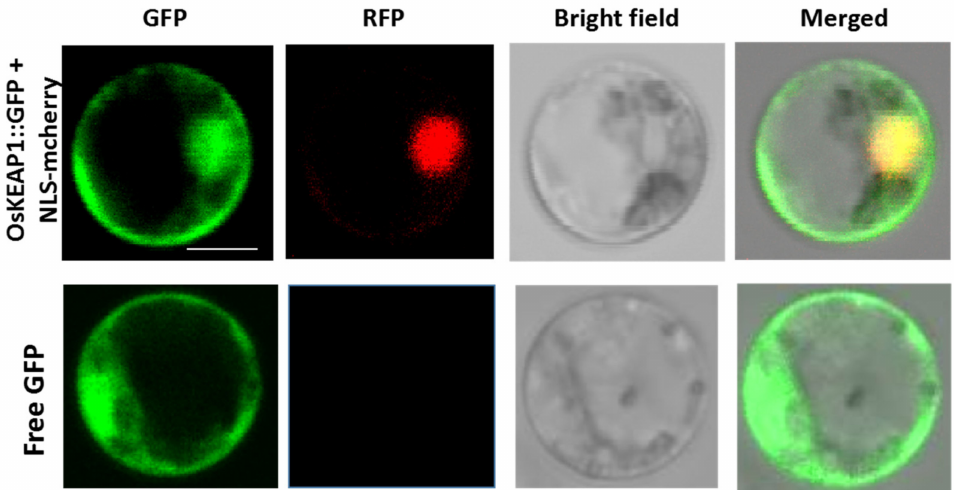
Figure 2. Transient expression of 35S:OsKEAP1:GFP fusion in rice protoplast. Protoplasts transfected with control vector (35S:GFP) have a bright GFP signal distributed throughout the cell, whereas those with 35S:OsKEAP1:GFP have a fluorescent signal (in green) localized in the nucleus and cytoplasm, confirmed by nuclear localization sequence (NLS) signal in the nucleus (in red). Bar = 5 µ m.